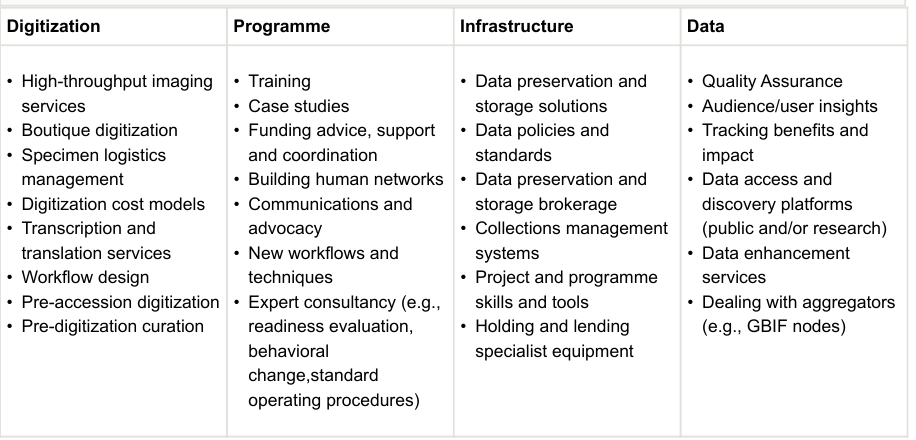
Table 6. Four service clusters of digitization-related services identified for DiSSCo.